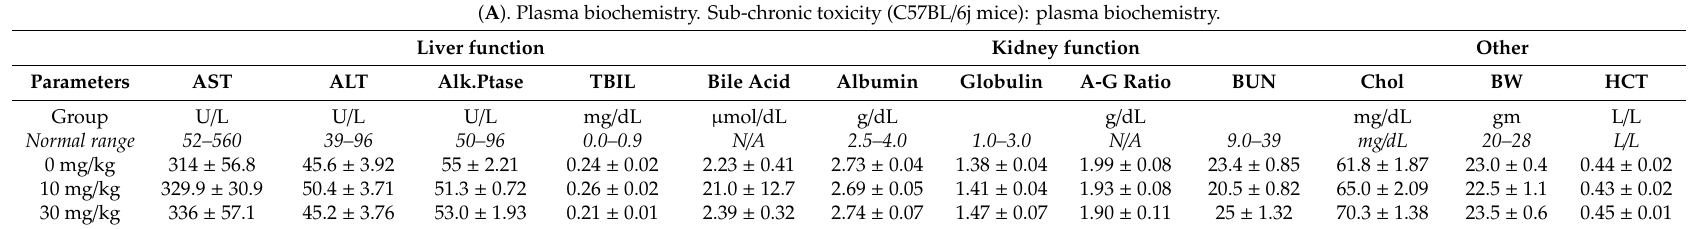
Table 4. Plasma biochemistry and Hematology